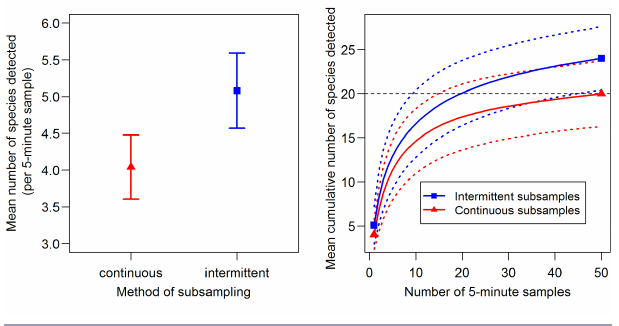
Fig. 4 . Mean number of species detected by continuous and intermittent subsampling of acoustic recordings: (a) mean species richness (± SE) of a single five-minute sample, (b) rarefaction curves of mean species richness (± 95% CI [dotted lines]) accumulated over 1 to 50 samples. The dashed horizontal line shows the total number of species detected across all 50 counts using the continuous method. The continuous method used continuous five-minute samples randomly selected from 30-minute acoustic recordings (n = 50); the intermittent method used the first 10 seconds of each minute to create a composite five minute